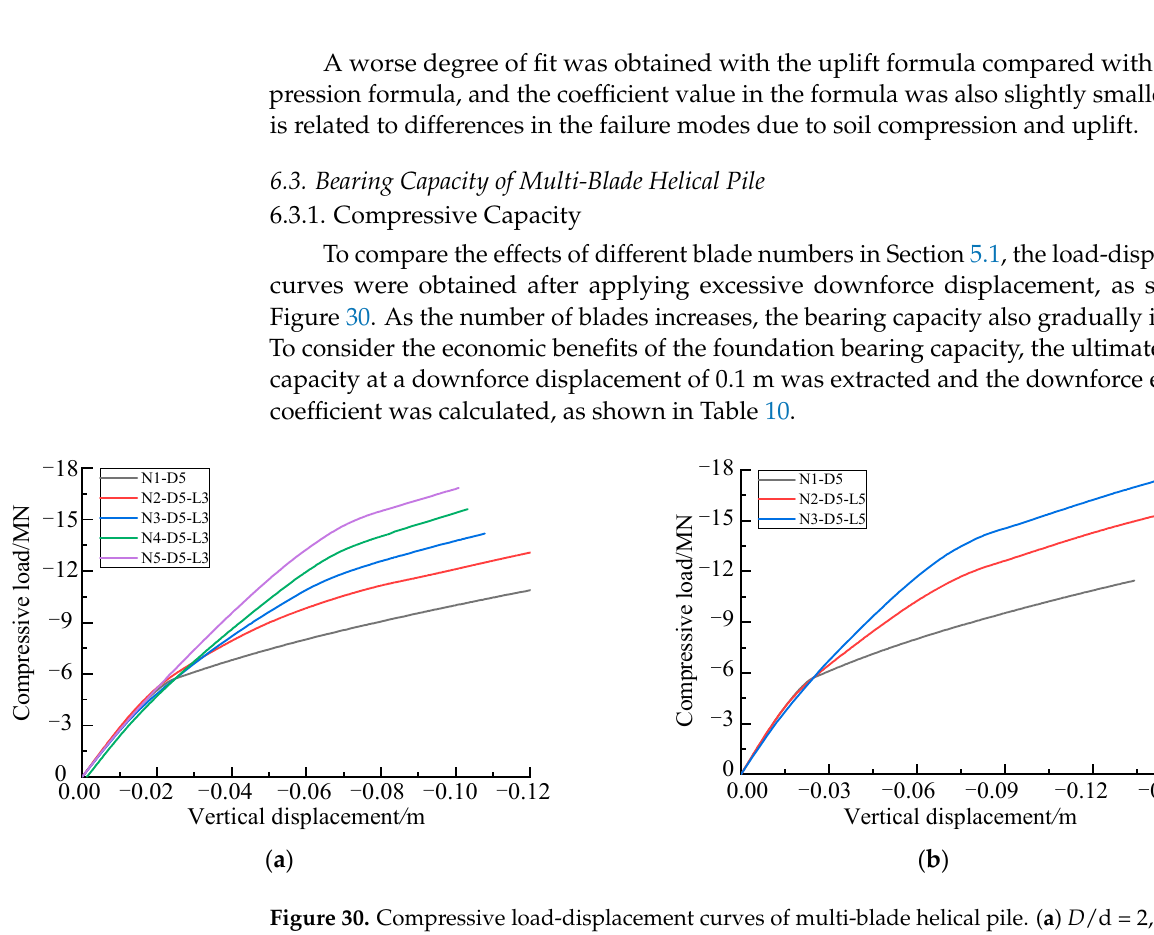
Table 10. Compression efficiency coefficient of multi-blade helical pile.